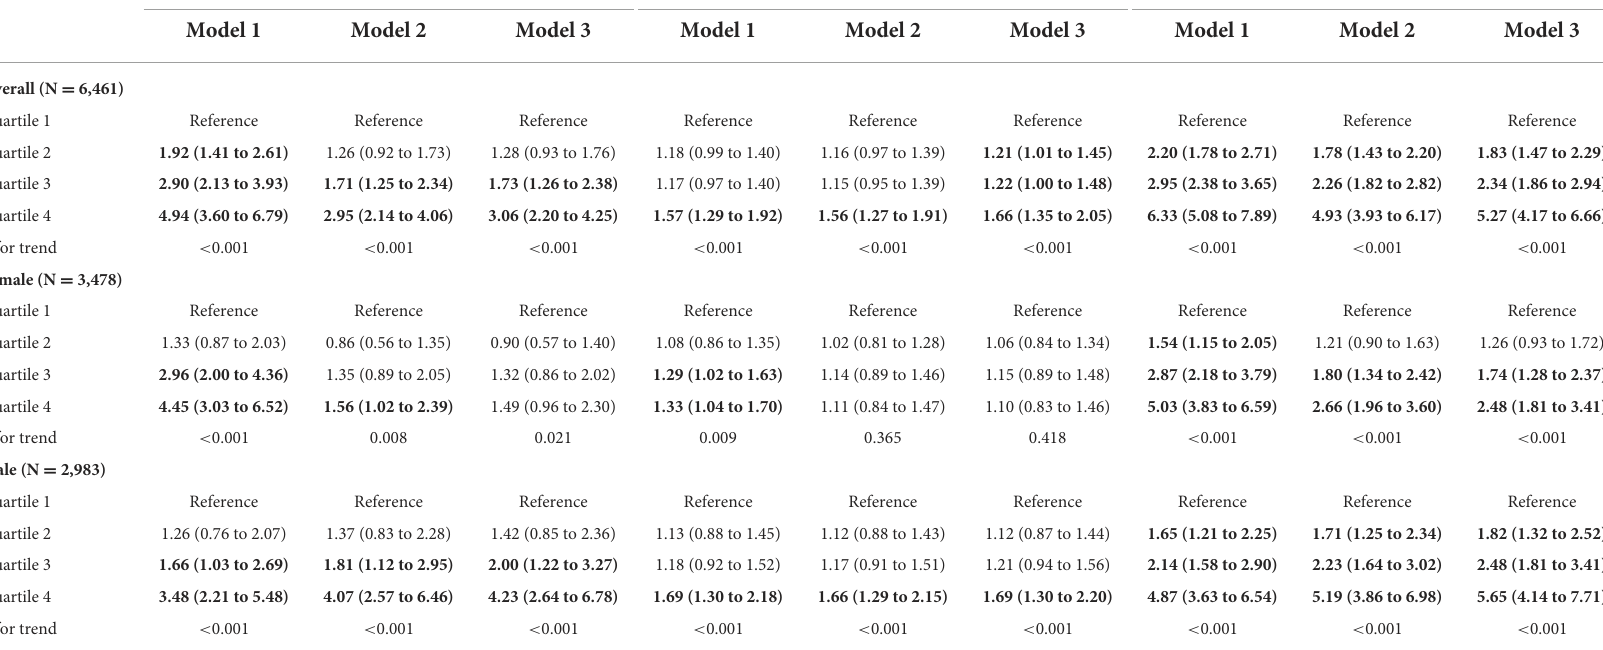
TABLE 2 Odds ratios and 95% CIs of different metabolic obesity phenotypes by ferritin levels in CHNS